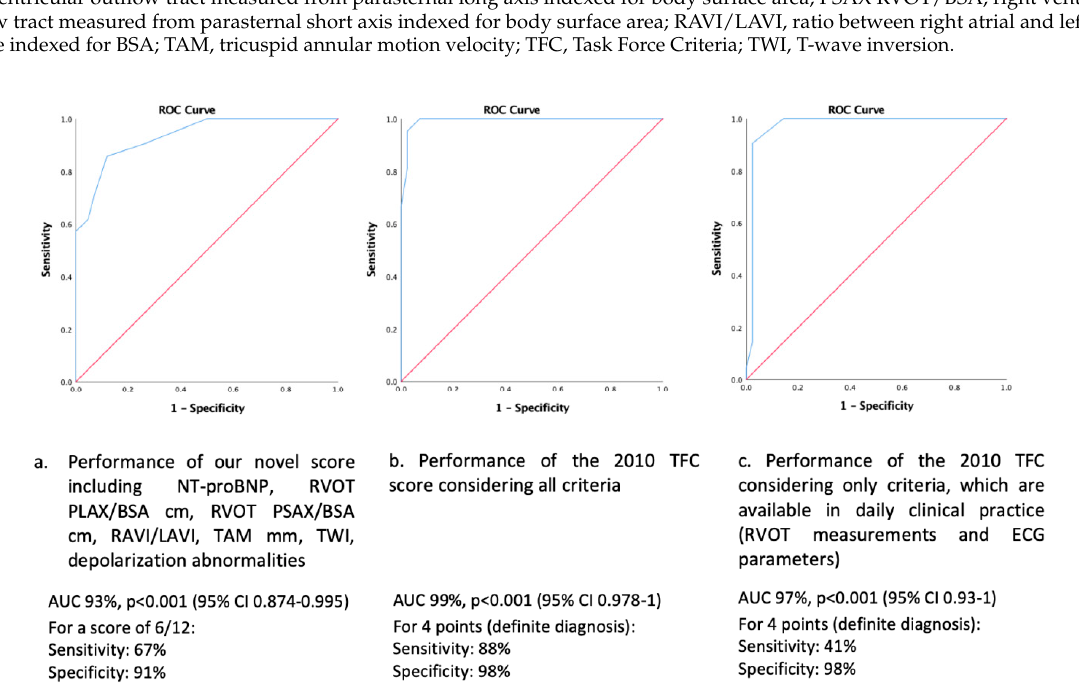
Figure 3. ROC curve for ARVC diagnosis. ( a ). performance of our novel score including NT-proBNP, RVOT PLAX/BSA, RVOT PSAX/BSA, RAVI/LAVI, TAM, TWI and depolarization abnormalities; ( b ). Performance of the 2010 Task